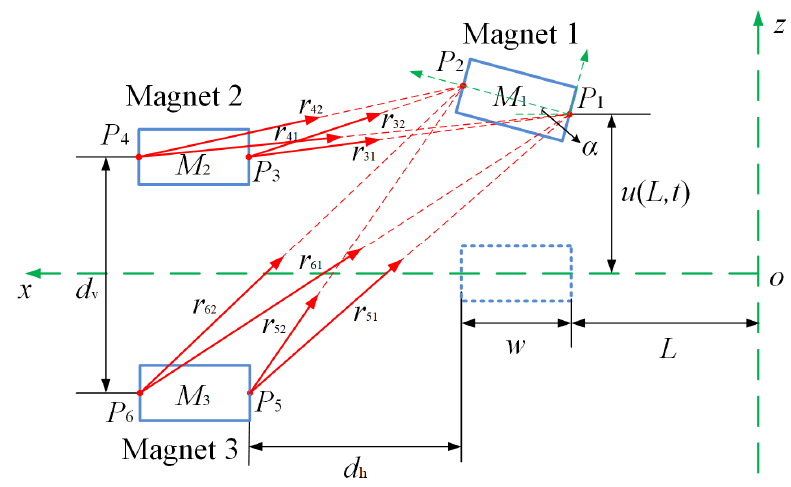
Figure 2. Geometric positions and relations of the magnet.